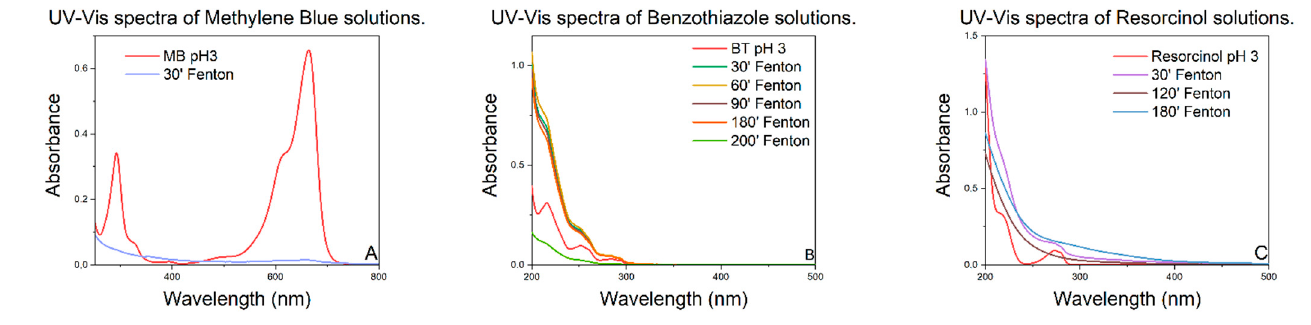
Figure 3. UV–vis spectra of model molecules solutions, over time.